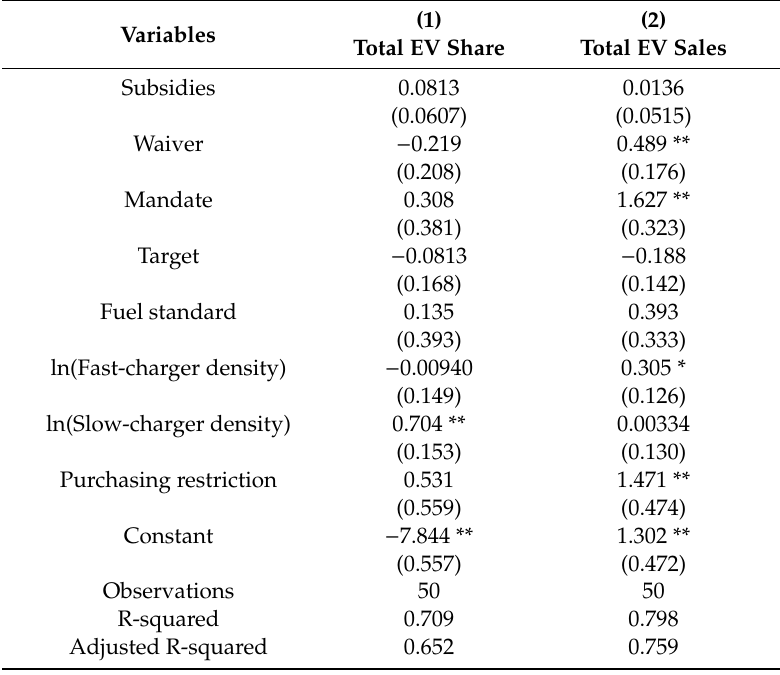
Table 7. Policy impact on total EV market using pooled